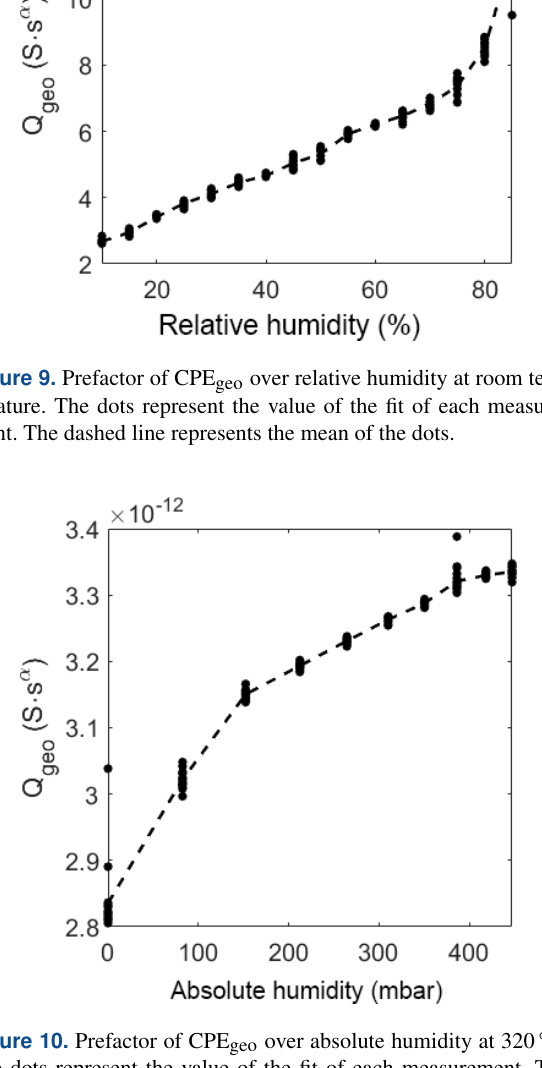
Figure 10. Prefactor of CPE geo over absolute humidity at 320 ◦ C. The dots represent the value of the fit of each measurement. The dashed line represents the mean of the